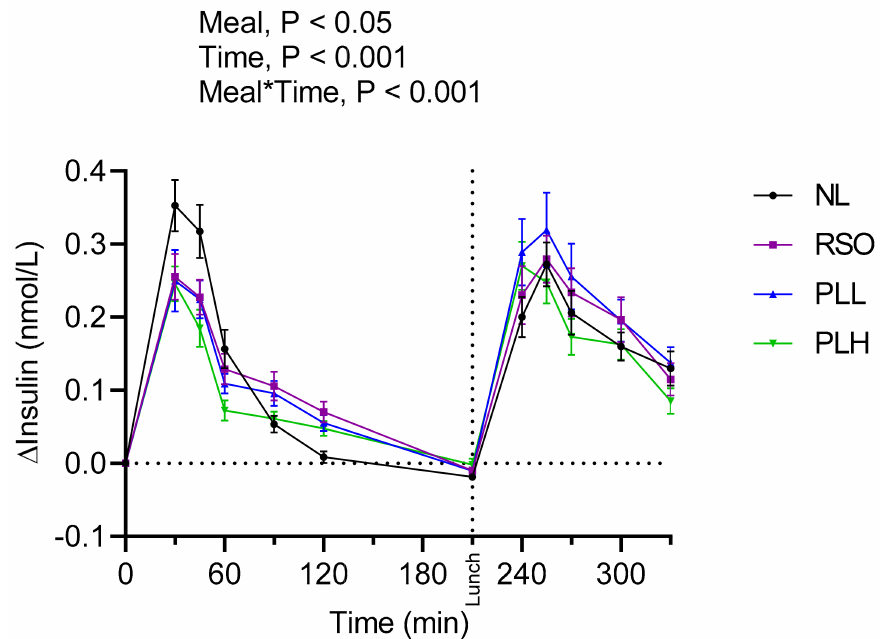
Figure 3. Postprandial incremental changes in blood serum insulin concentrations after test breakfasts and standardized lunch meals. Values are means ± SEM, n = 20 healthy subjects. Repeated measures; mixed model in SAS. NL, oat preparation without added lipids; RSO, oat preparation added with rapeseed oil; PLL, oat preparation with a low concentration of polar lipids; PLH, oat preparation with a high concentration of polar